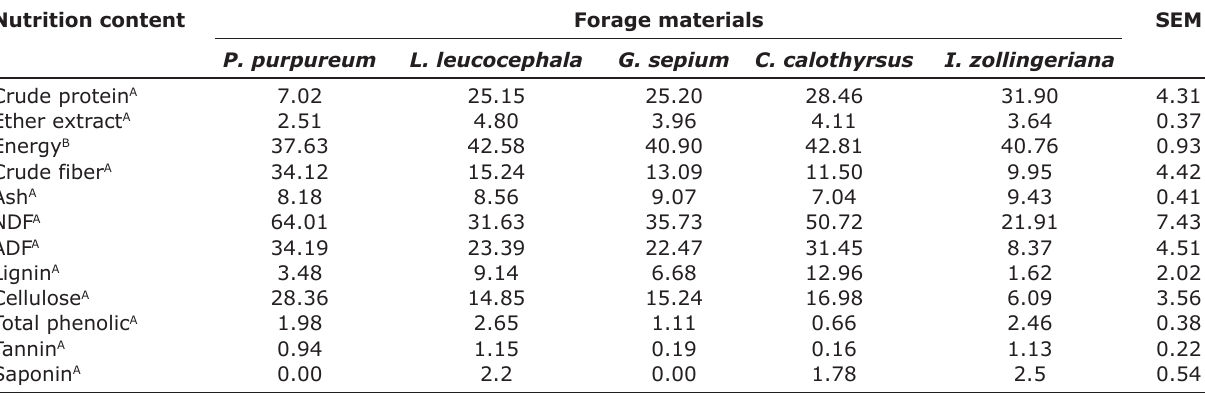
Table-1: Nutrition content of forage materials. Nutrition content Forage